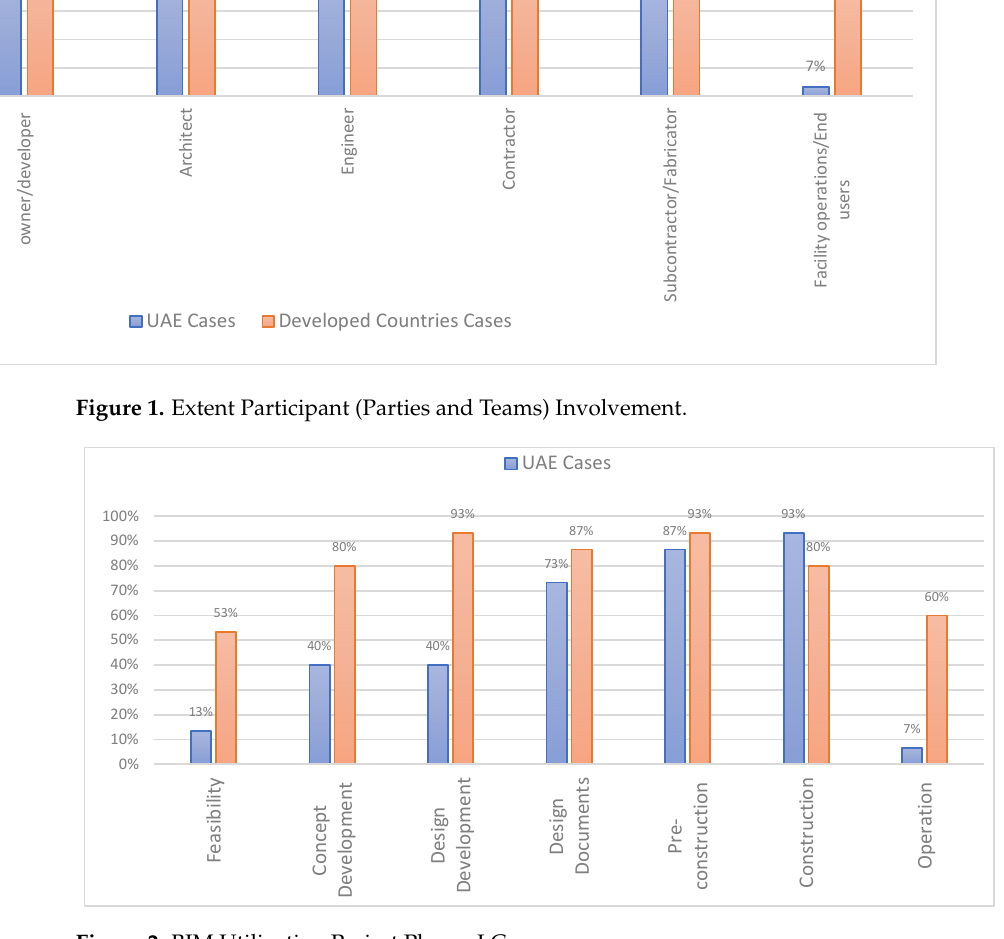
Figure 2. BIM Utilization Project Phases LC. Table 2. Mapping of Criteria to BIM Cases.